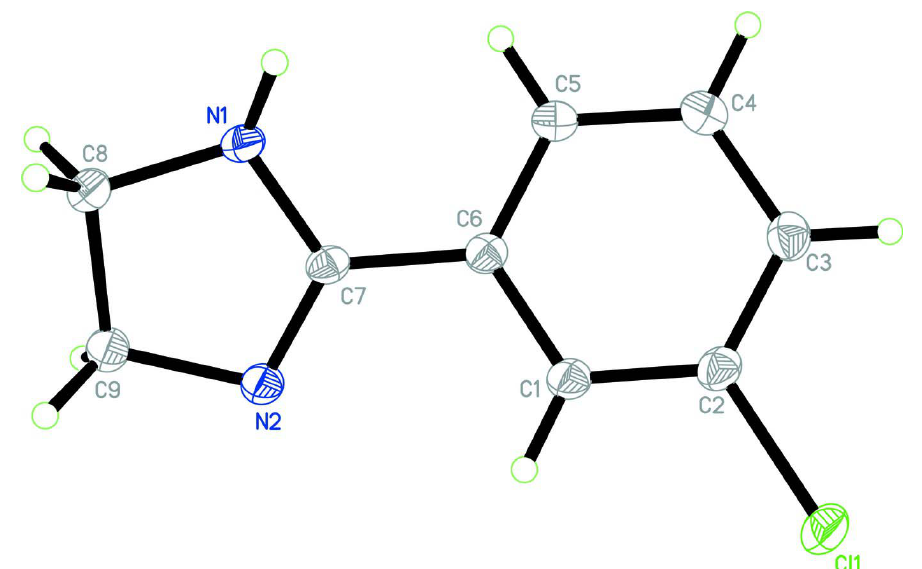
Figure 1 The molecular structure of (I) with atom labels and 50% probability ellipsoids for non-H atoms.